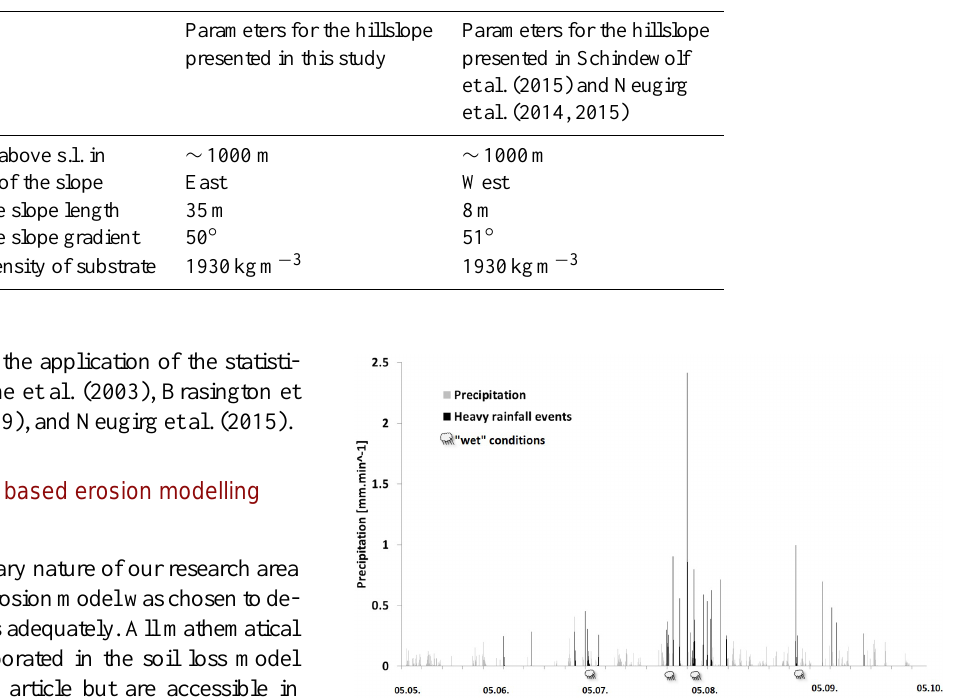
Table 1. Topographical data and relief parameter.